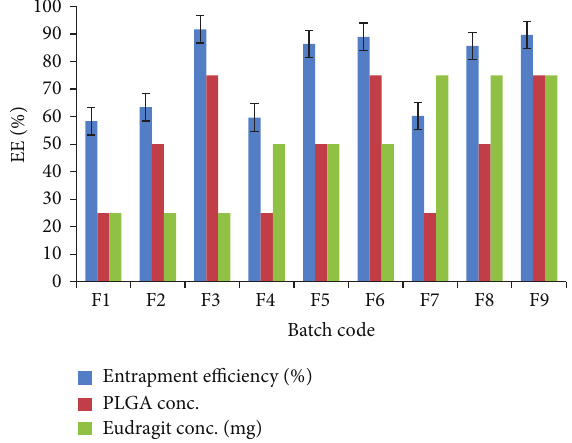
Figure 5: Effect of polymer concentration on percent entrapment